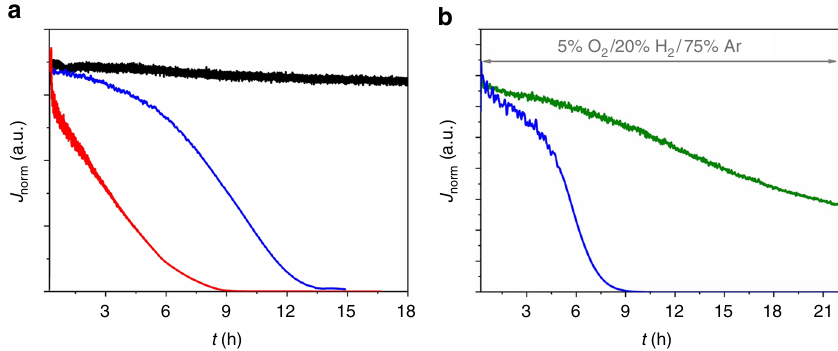
Fig. 3 Long-term stability of the polymer multilayer-based bioanodes. Chronoamperometric long-term stability measurements of the double-layer bioanodes in 0.1 M phosphate buffer, pH 7.4 at an applied potential of + 160 mV vs. standard hydrogen electrode (SHE) under turnover conditions and in the presence of O 2 . a Black trace: P(N 3 MA-BA-GMA)-vio/ Dv MF-[NiFe]//P(SS-GMA-BA)/GOx/CAT system with 20% H 2 /80% Ar bubbling through the cell and in the absence of glucose; red trace: single P(N 3 MA-BA-GMA)-vio/ Dv MF-[NiFe] layer, 5% O 2 /20% H 2 /75% Ar; blue trace: P(N 3 MA-BA-GMA)- vio/ Dv MF-[NiFe]//P(SS-GMA-BA)/GOx/CAT system with 5% O 2 /20% H 2 /75% Ar bubbling through the cell and 100 mM glucose; the same enzyme batch was used for all three experiments. b Comparison between the protection systems based on GOx (P(N 3 MA-BA-GMA)-vio/ Dv MF-[NiFe]//P(SS- GMA-BA)/GOx/CAT, blue line) and Py 2 Ox (P(N 3 MA-BA-GMA)-vio/ Dv MF-[NiFe]//P(SS-GMA-BA)/Py 2 Ox/CAT, green line) with 5% O 2 /20% H 2 /75% Ar bubbling through the electrolyte and with 50 mM glucose in solution; the same enzyme batch was used for both measurements. For comparative purposes the current densities were normalized to the current fl ow at 100% H 2 ( J norm ) to eliminate variations in J (for absolute current values ( I )